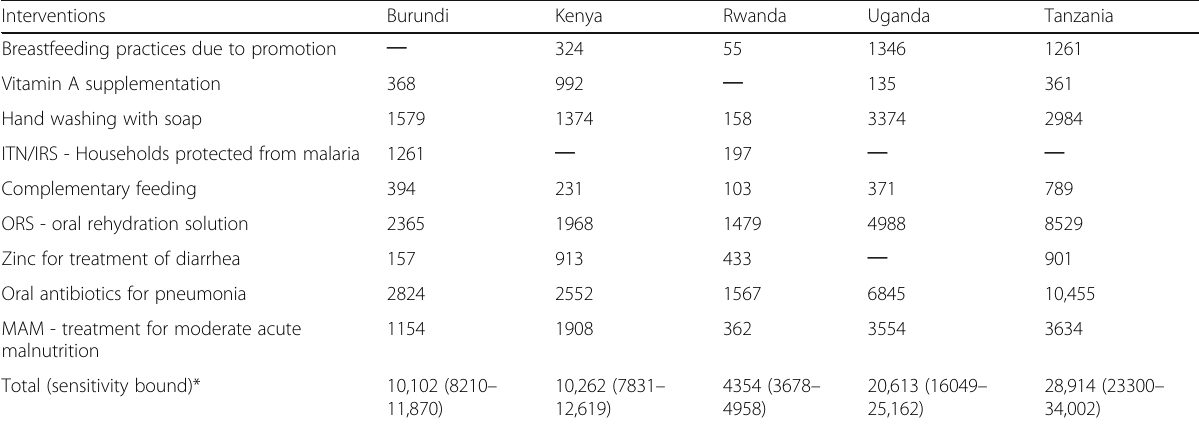
Table 4 Number of deaths averted by target year (2030) by intervention under ideal coverage scenario relative to BAU scenario Interventions Burundi Kenya Rwanda Uganda Tanzania Breastfeeding practices due to promotion ─ 324